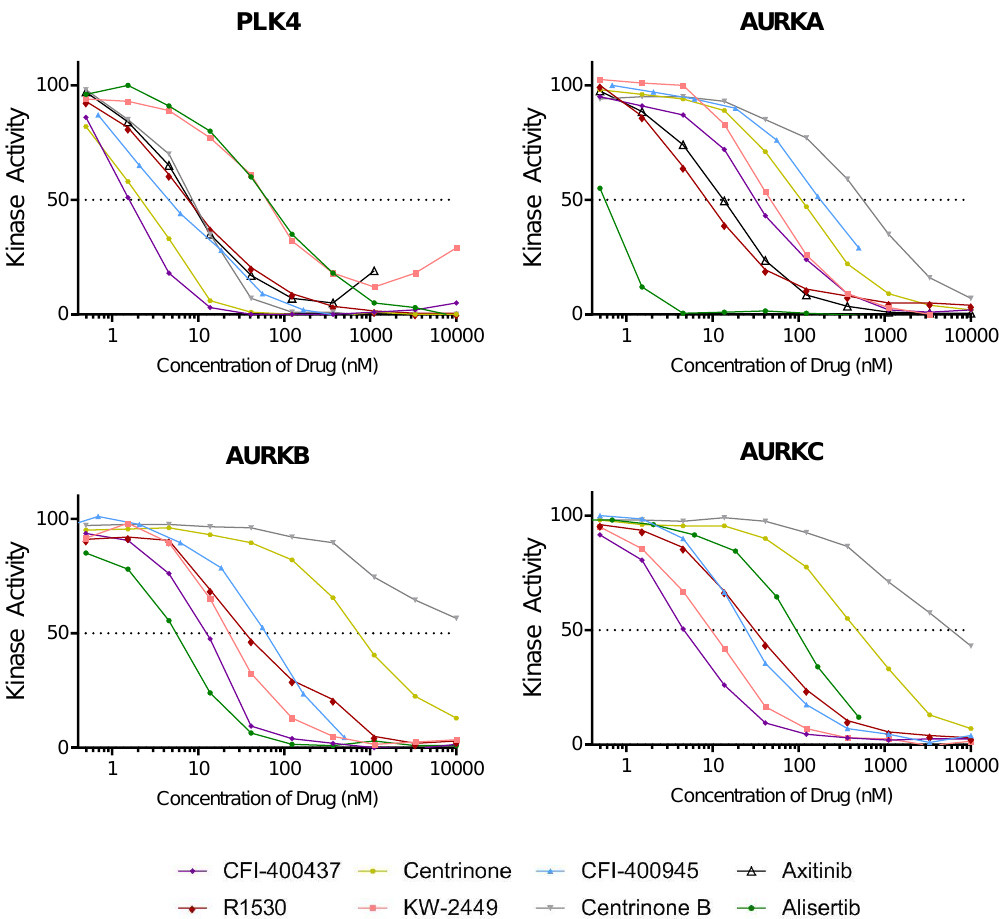
Figure 3. Kinase activity curves for PLK4, Aurora kinase A (AURKA), Aurora kinase B (AURKB), and Aurora kinase C (AURKC) in the presence of various concentrations of for each inhibitor. (SelectScreen™ Kinase Profiling Services — Thermo Fisher Scientific, Carlsbad, CA, USA).